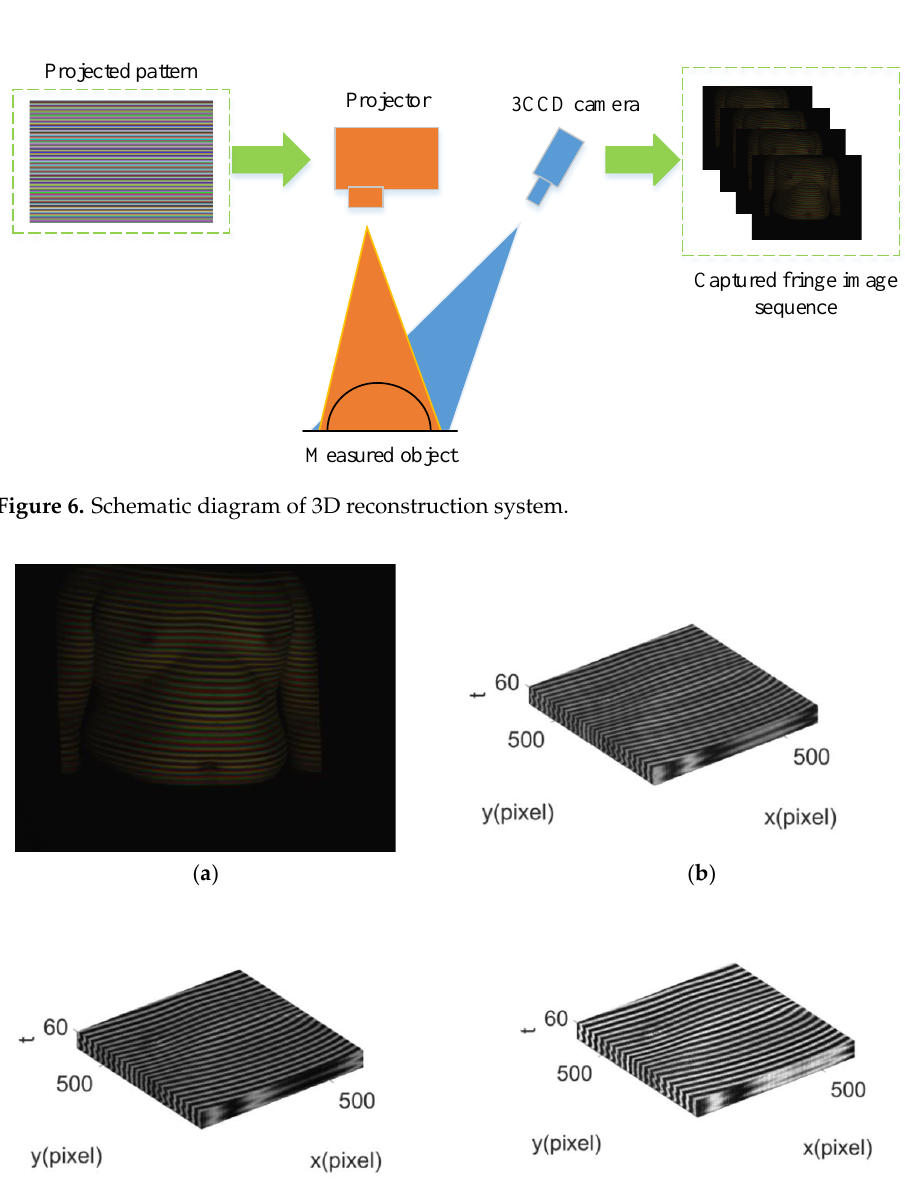
represent the phase. Figure 5 shows composite fringe pattern. R G B Figure 5. Composition of color-encoded fringe pattern. 3.2.2. Three-Dimensional Reconstruction System and Color Separation Our paper uses the red, green, and blue channels of color images to encode the fringe